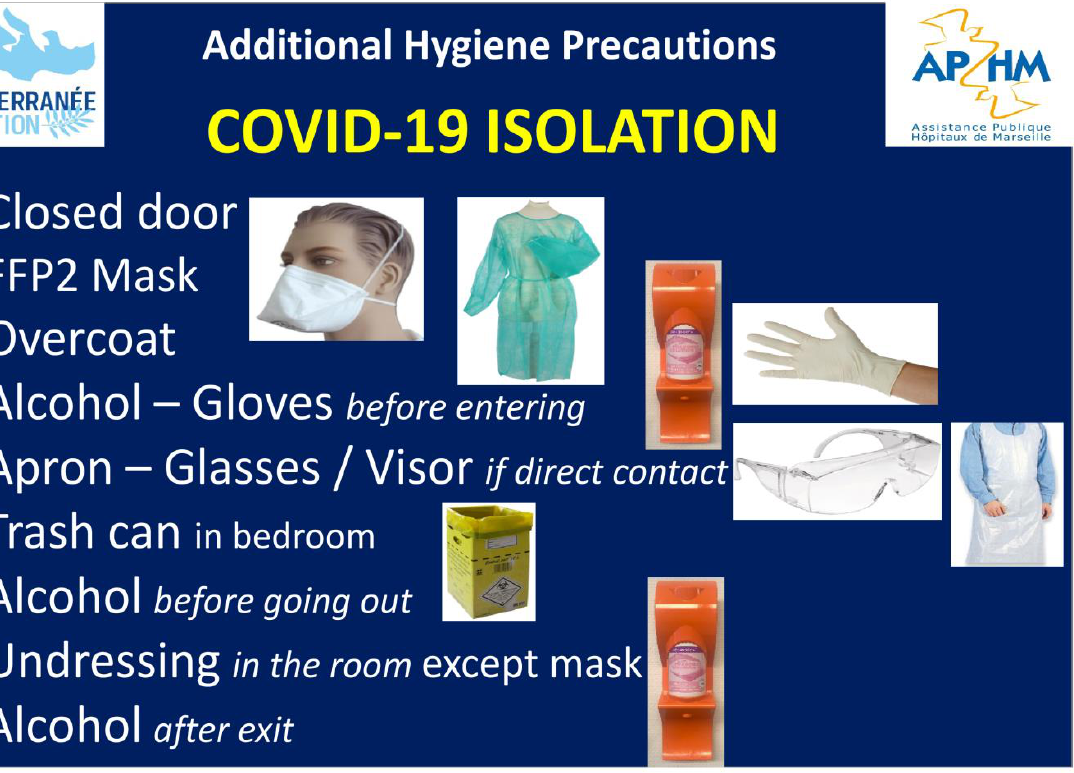
Figure 4. Specific sign placed on the doors of COVID-19 patient rooms.